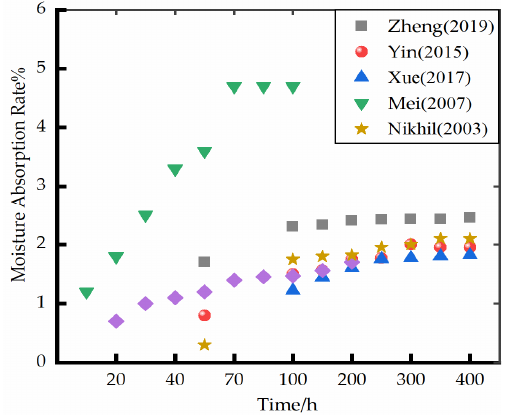
Figure 5. Variation curve of moisture absorption rate of polyurethane foam materials with soaking time [28,35,64,70,84].